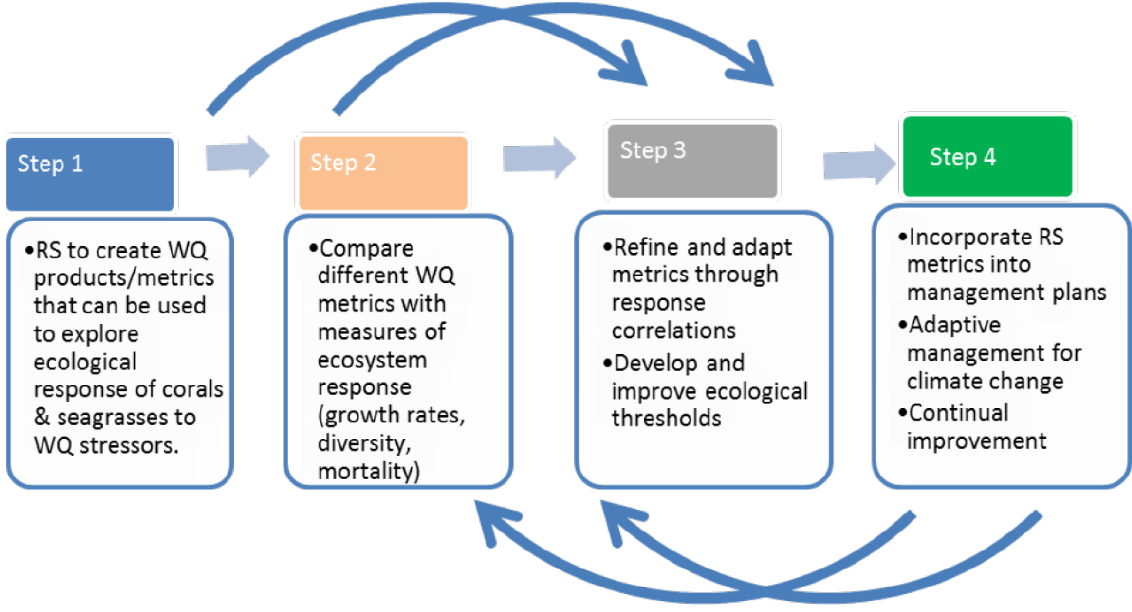
Figure 8. Adaptive strategy for the inclusion and use of RS products in the mapping and monitoring of GBR water quality and